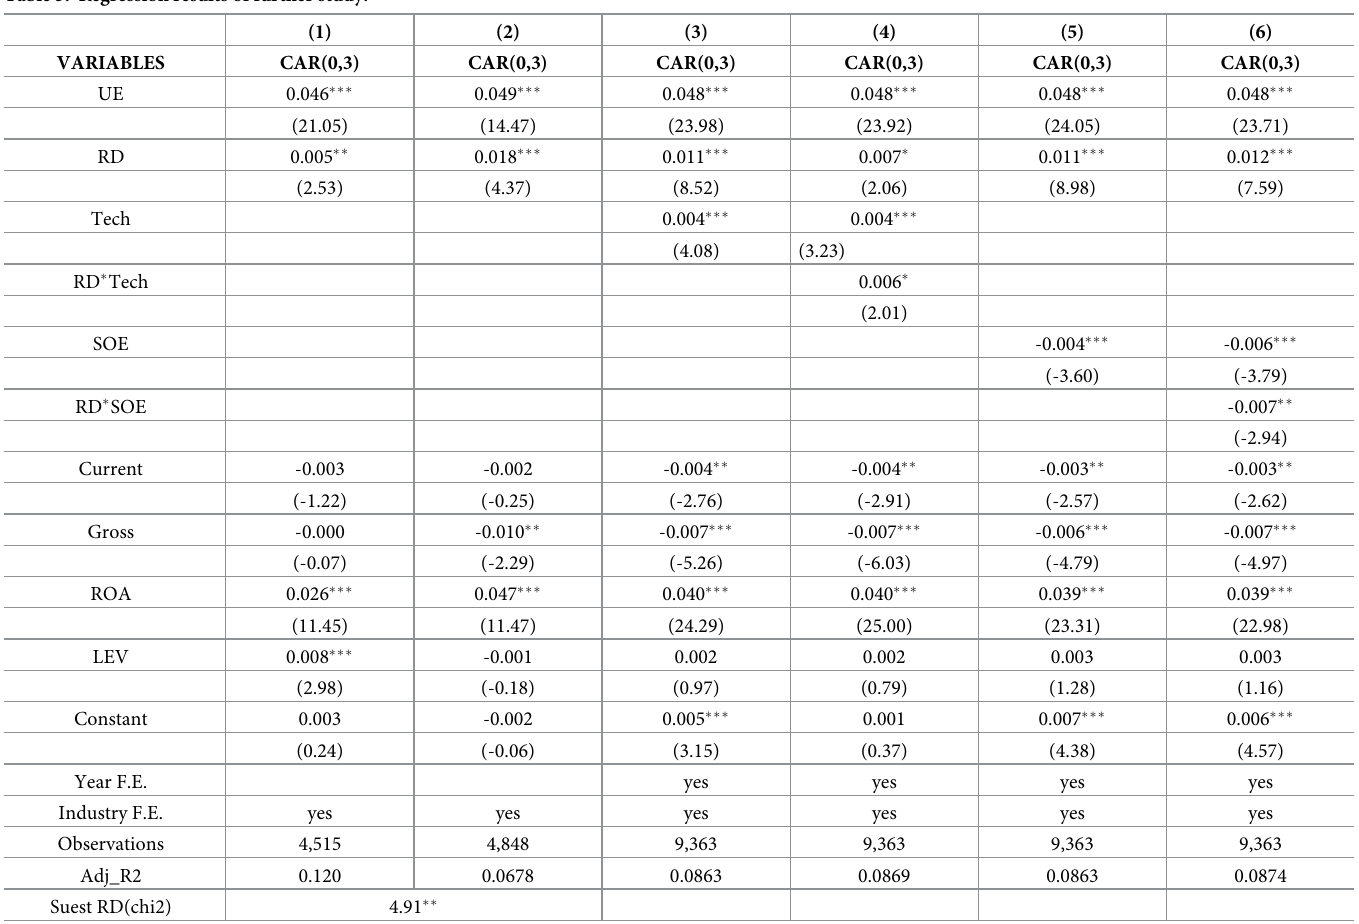
Table 5. Regression results of further